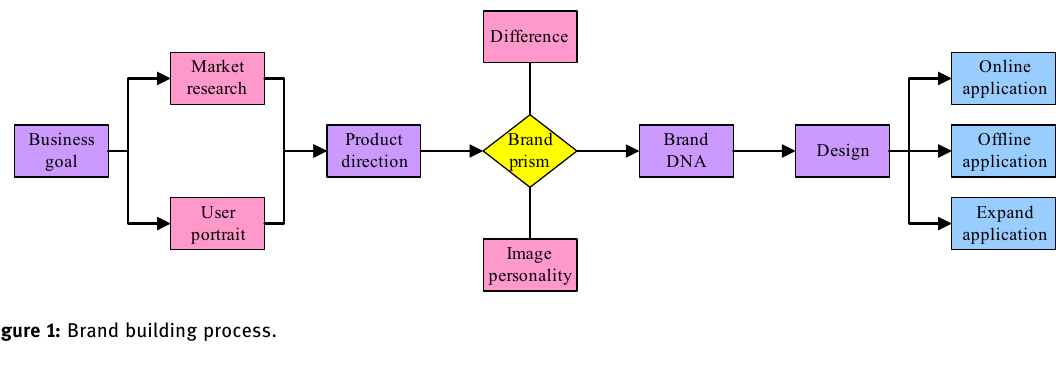
Figure 1: Brand building